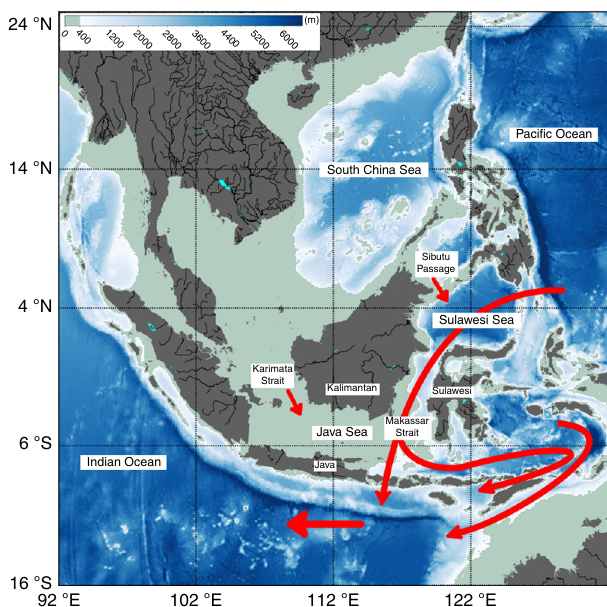
Fig. 1 Bathymetric map for the southeast Asian Seas and the major pathways of ocean currents in the Maritime Continent region. The schematic illustration is based on refs.